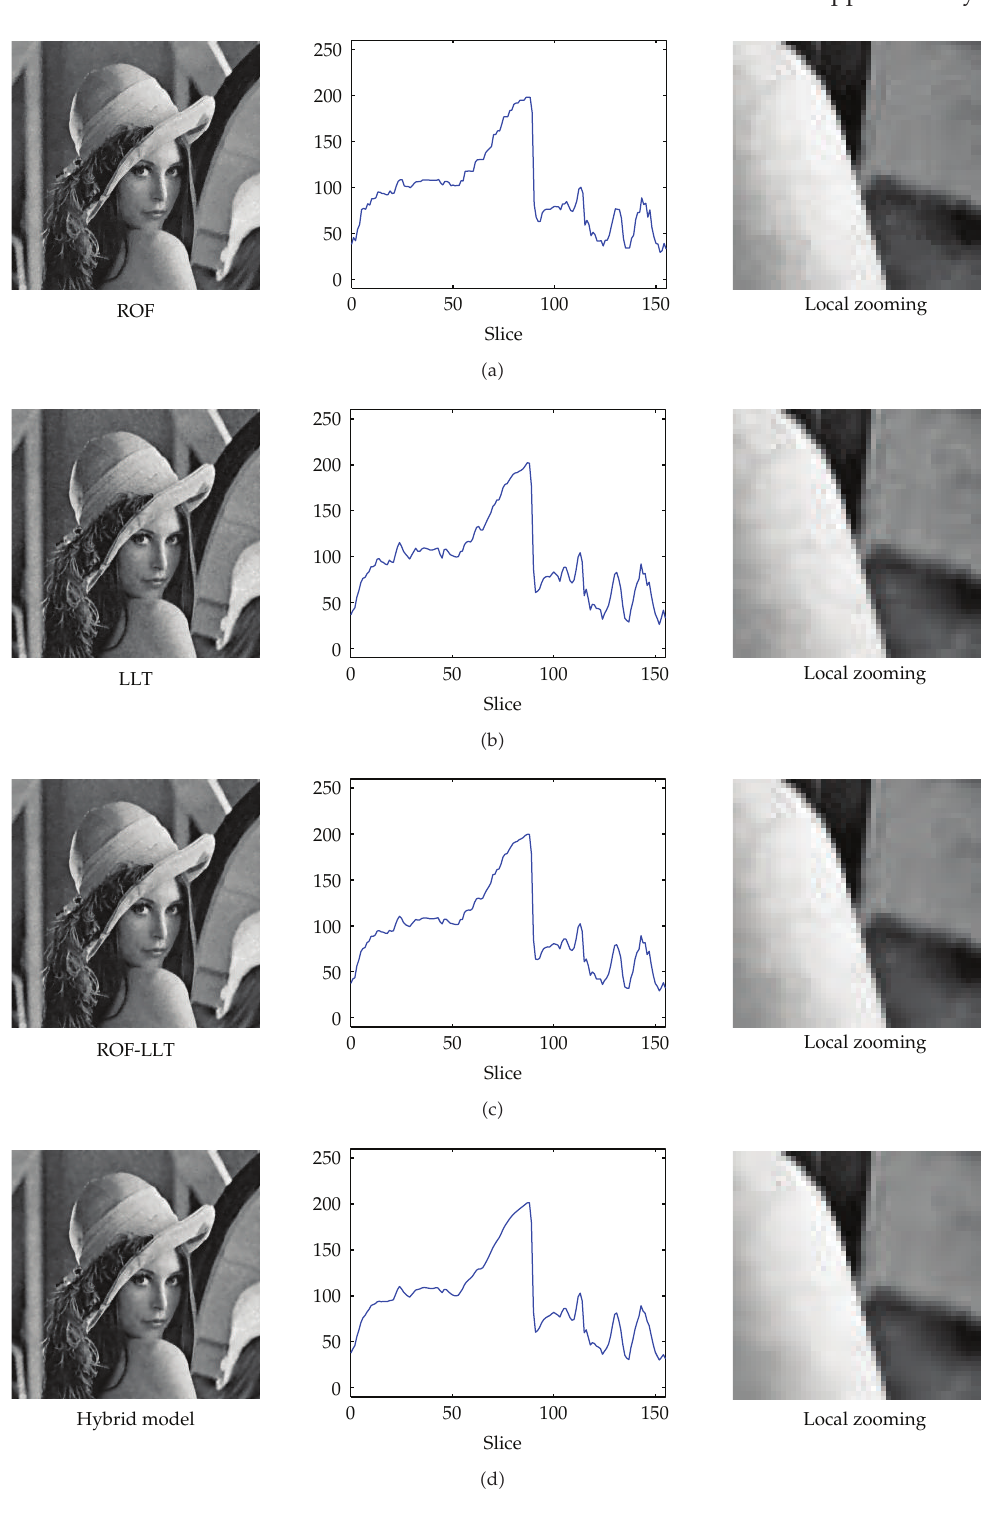
Figure 3: The related restored images in Example